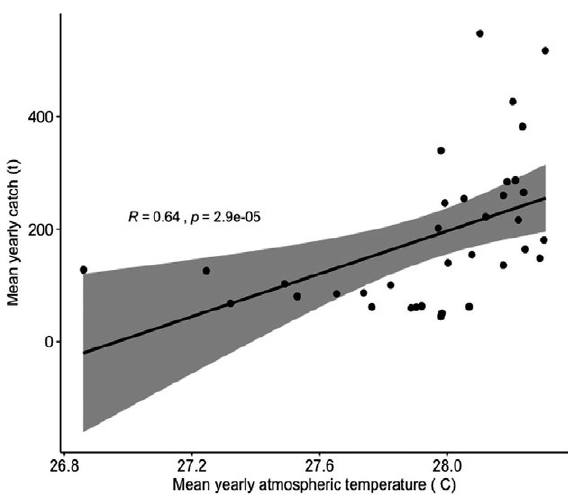
Fig. 3. – Mean yearly skipjack catch as a function of the atmospheric temperature in the Maldives for